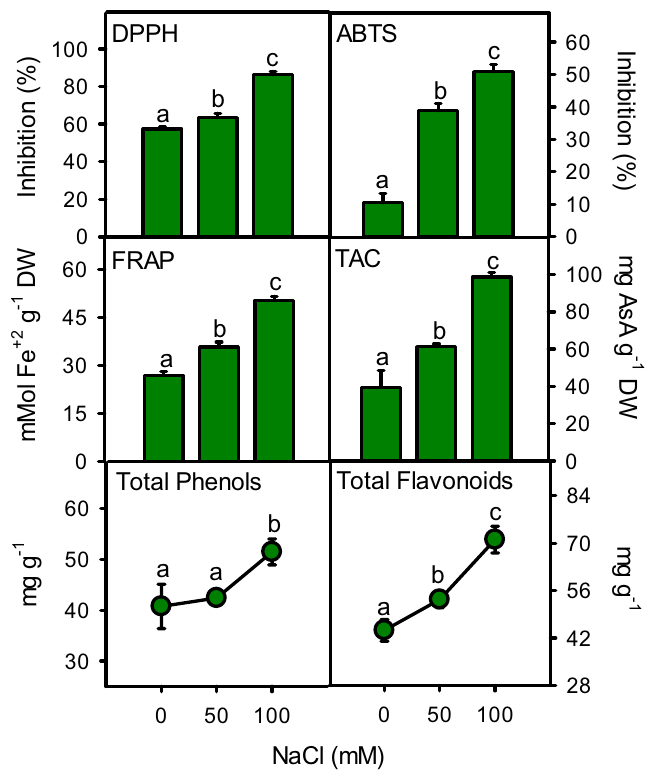
Figure 10. Antioxidant capacity (DPPH, ABTS, FRAP and TAC), total phenols and flavonoid contents in Moringa oleifera under different salinity treatments. Different letters indicate significant differences at P <